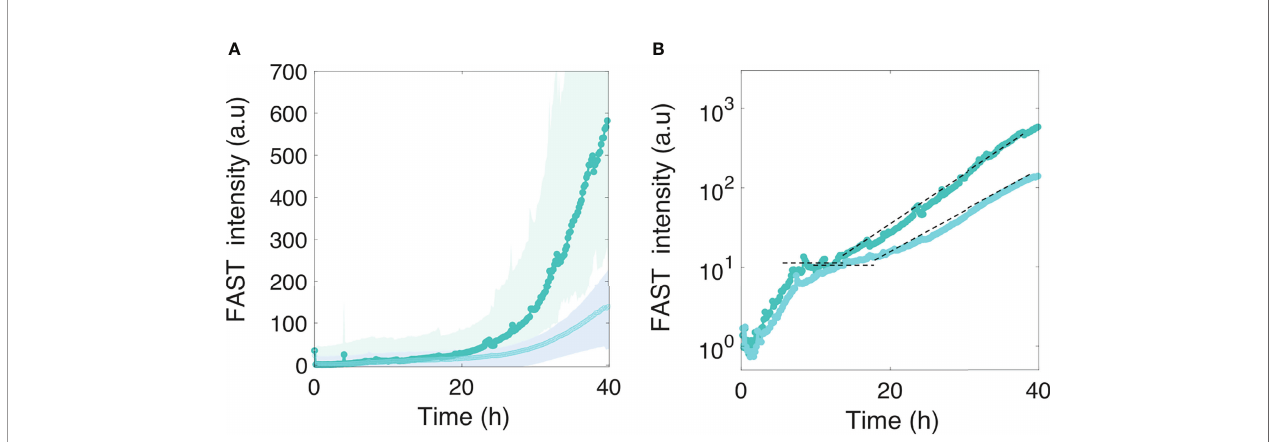
FIGURE 5 | Motile and nonmotile E. coli surface colonization in the presence of co-colonizers. Motile (in light cyan) and nonmotile (in dark cyan) E. coli surface fl uorescence (A) in the bio fi lm formed in the presence of the four co-colonizers Bt, Pf, Kv and Rh . The logarithmic display (B) highlights two distinct phases in E. coli development in the composite multispecies bio fi lm. The dashed lines indicate the level of the fi rst phase plateau and the second phase growth rate. Curves are from the average intensity of 3 distinct positions from 2 different channels (2 biological replicates) with the shaded area representing the standard deviation.